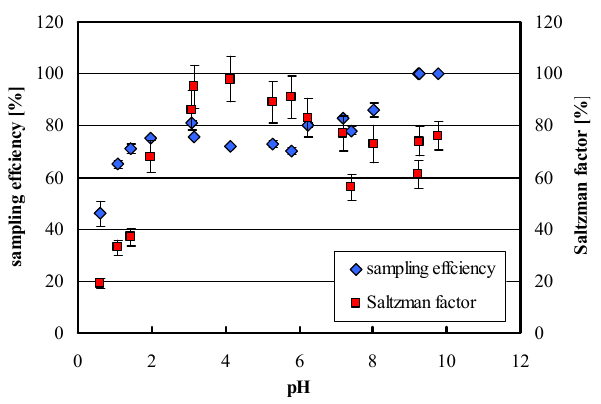
Fig. 2. Variation of the sampling efficiency and the Saltzman fac- Variation of the sampling efficiency and the Saltzman factor with pH. Griess- tor with pH. Griess- Saltzman reagent: 1gl − 1 NEDA, 5gl − 1 sul- Saltzman reagent: 1 g/l NEDA, 5 g/l sulphanilamide, 7.2 g/l HCl was used here phanilamide, 7.2gl − 1 HCl was used here instead of acetic acid, pH adjusted by the addition of NH 3 . Air flow=1000mlmin − 1 , liquid instead of acetic acid, pH adjusted by the addition of NH 3 . Air flow = flow=0.27mlmin − 1 . 1000 ml/min, liquid flow = 0.27 ml/min.